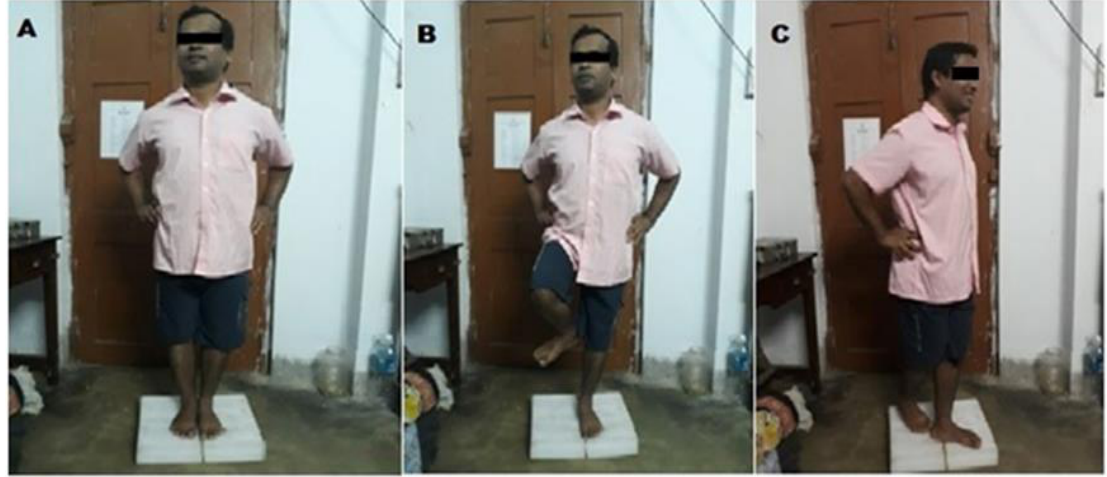
Figure 2. A. Double Leg stance; B. Single Leg stance; C. Tandem stance on the foam (soft) surface in both Non-Dominant Leg (NDL) and Dominant Leg